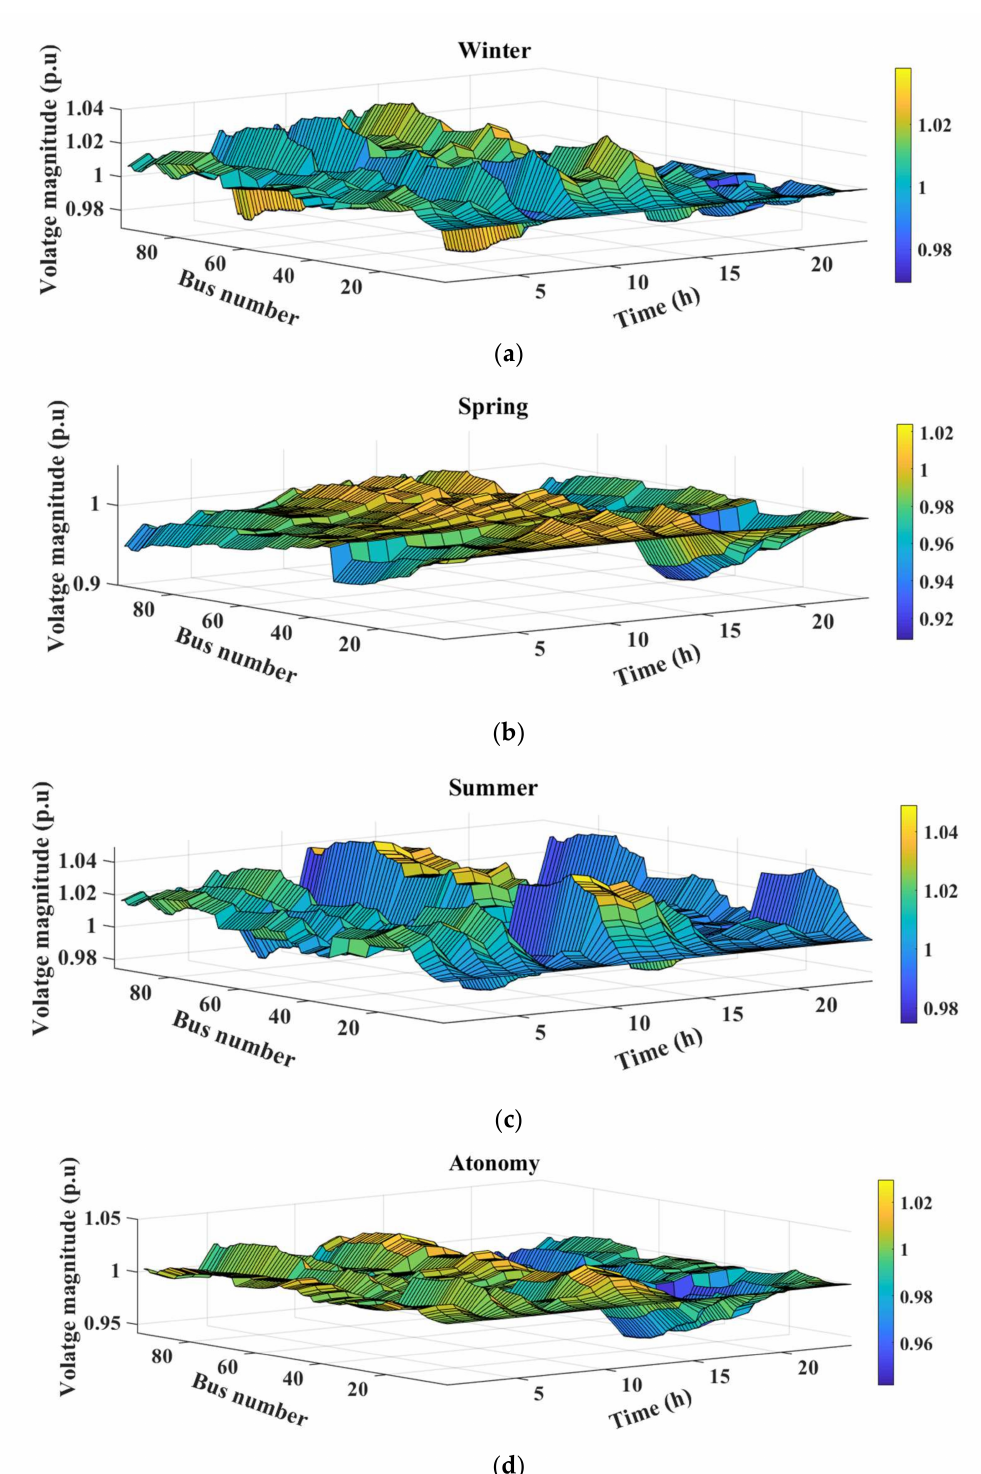
Figure 13. System voltages magnitude ( a ) in Winter, ( b ) in Spring, ( c ) in Summer, ( d ) in